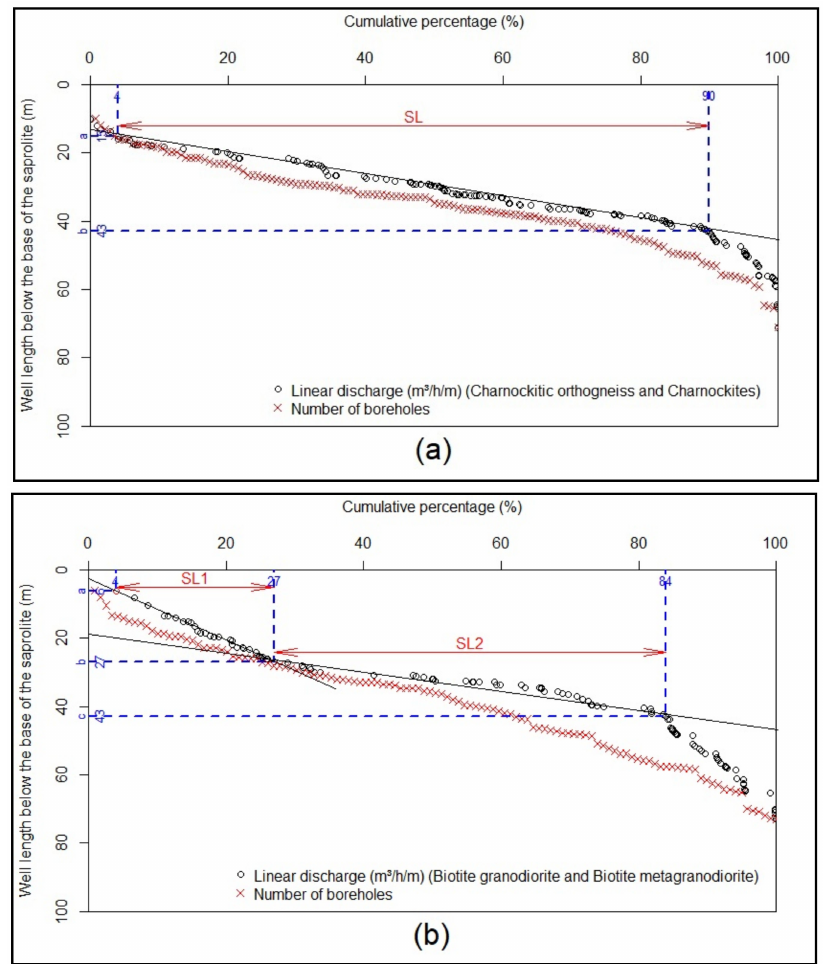
Figure 10. Cumulative percentage of linear discharge of the fractured layer for the lithologies ( a ) Charnockitic orthogneiss and Charnockites (N = 145) and ( b ) Biotite granodiorite and Biotite metagranodiorite (N =